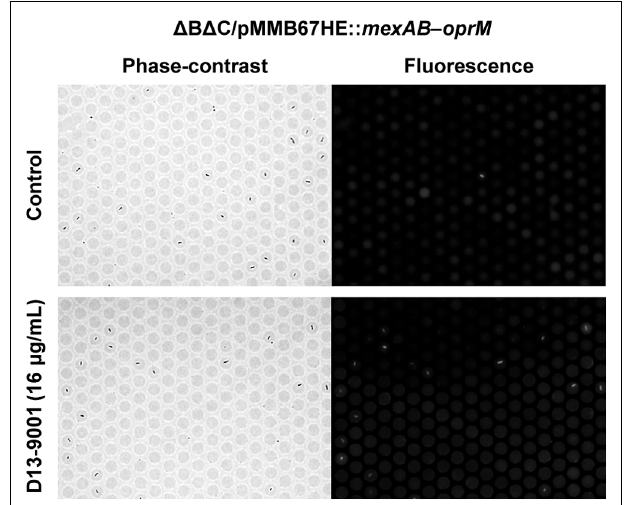
FIGURE 5 | Effect of the pump inhibitor D13-9001 on the efflux activity of MexAB-OprM expressed in the (cid:2) B (cid:2) C E. coli strain. Phase-contrast (left) and fluorescence (right) images of untreated control cells (top) or cells treated with 16 μ g/mL D13-9001 (bottom).